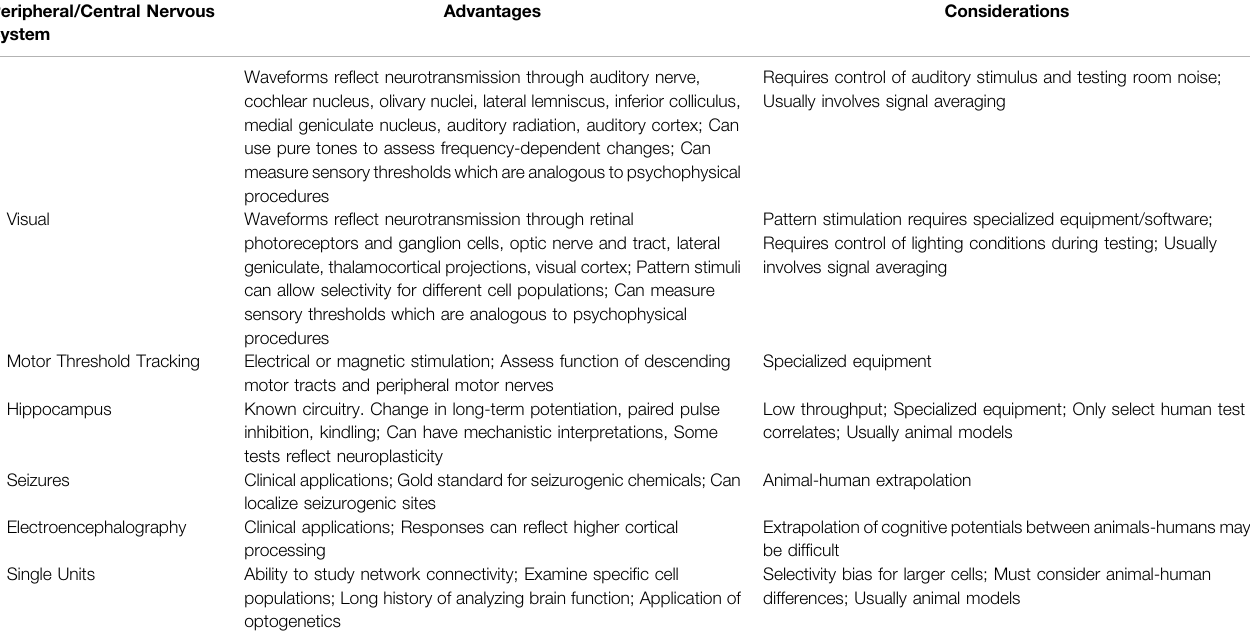
TABLE 1 | ( Continued ) Example types of neuroelectrophysiological